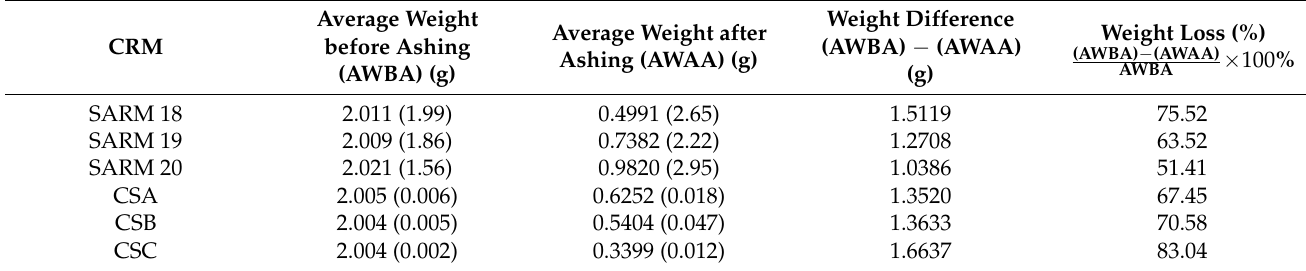
Table 3. Coal CRM percentage weight loses after MAA in replicates ( n =